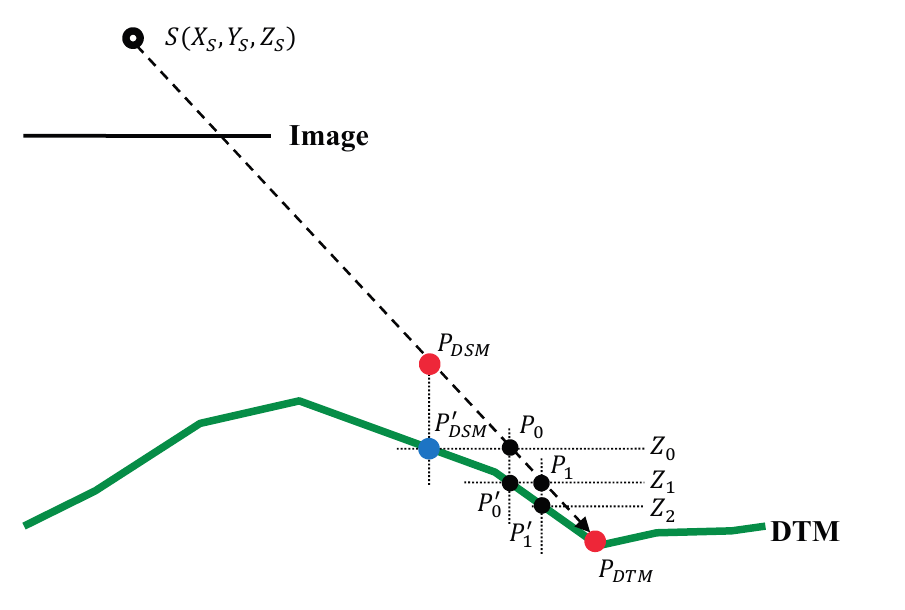
and a (cid:3005)(cid:3020)(cid:3014)